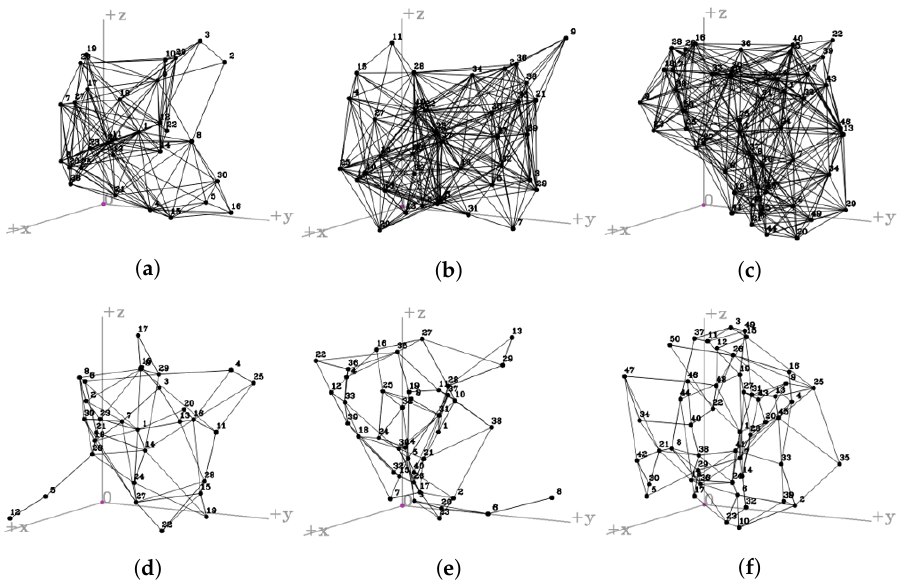
Figure 6. Network connectivity of arbitrary UAV formations after training: ( a ) Full connection of 30 UAVs. ( b ) Full connection of 40 UAVs. ( c ) Full connection of 50 UAVs. ( d ) Network topology control of 30 UAVs. ( e ) Network topology control of 40 UAVs. ( f ) Network topology control of 50